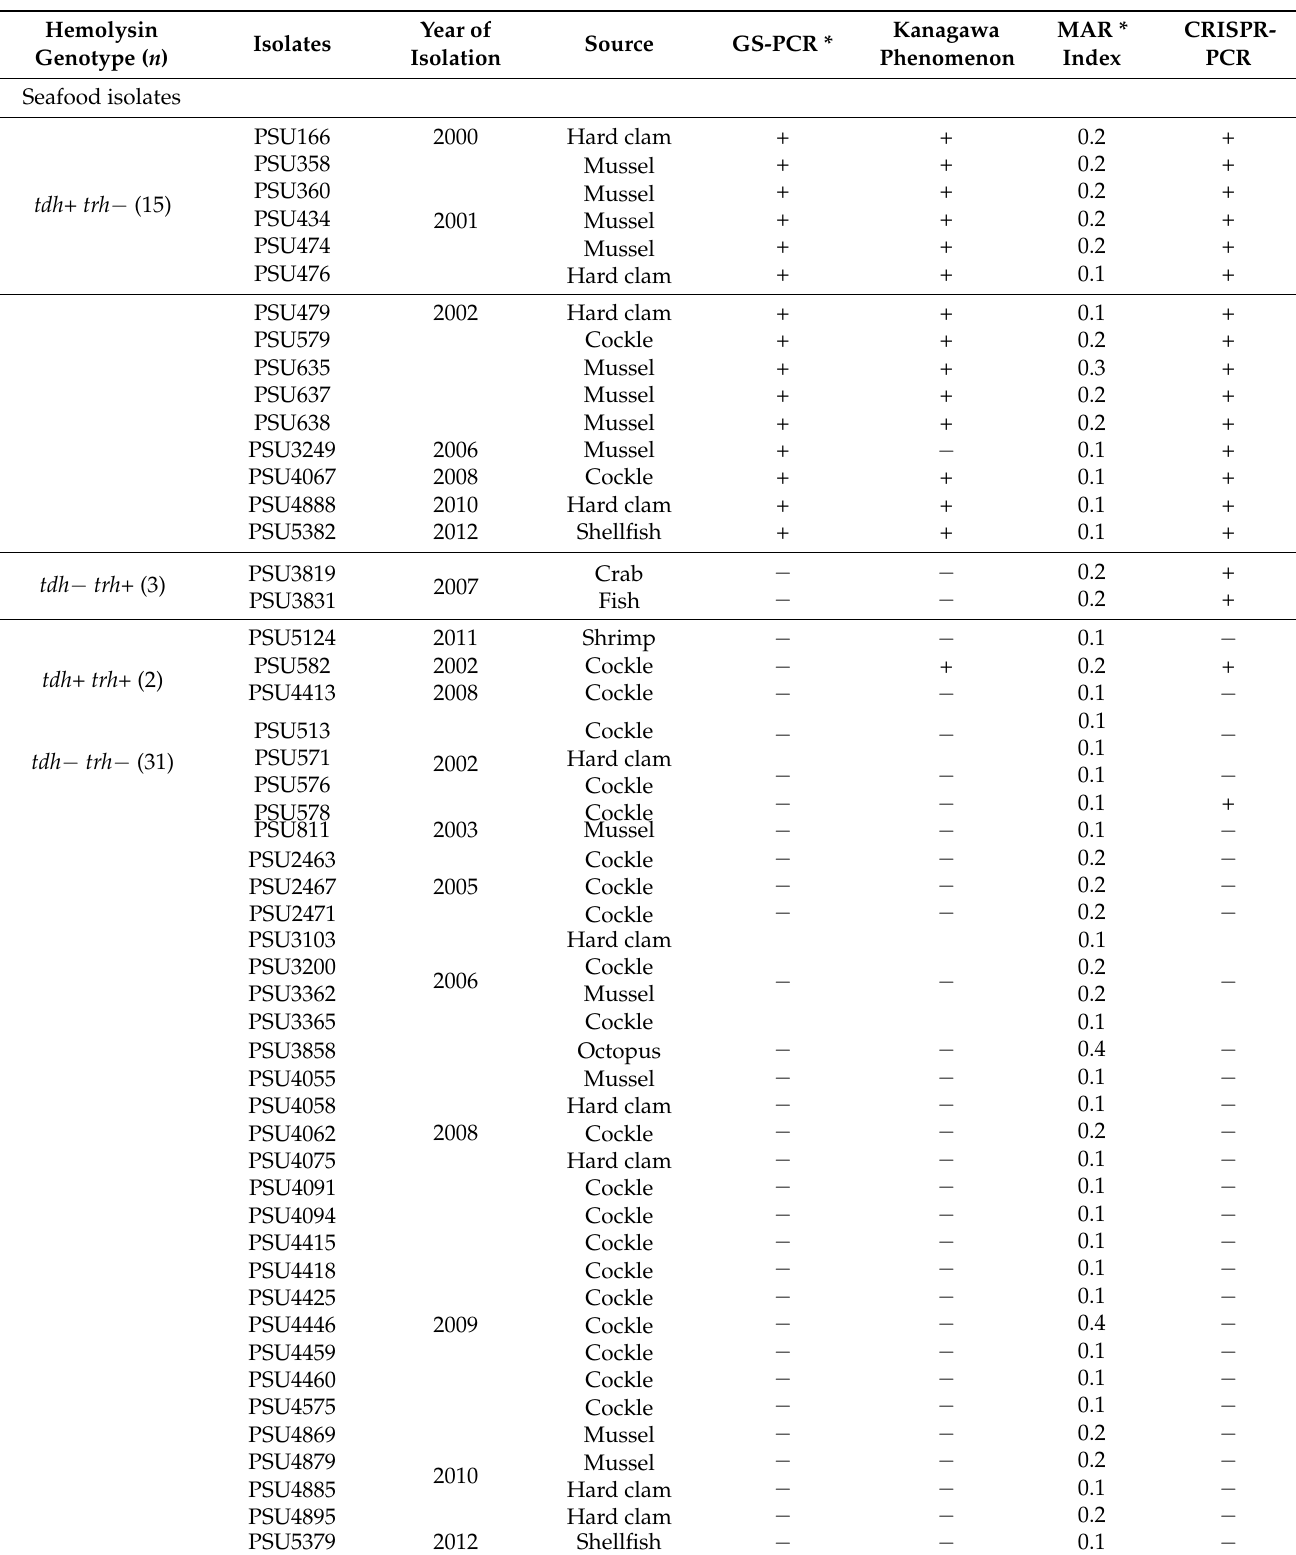
Table 1. V. parahaemolyticus isolates used in this study and their